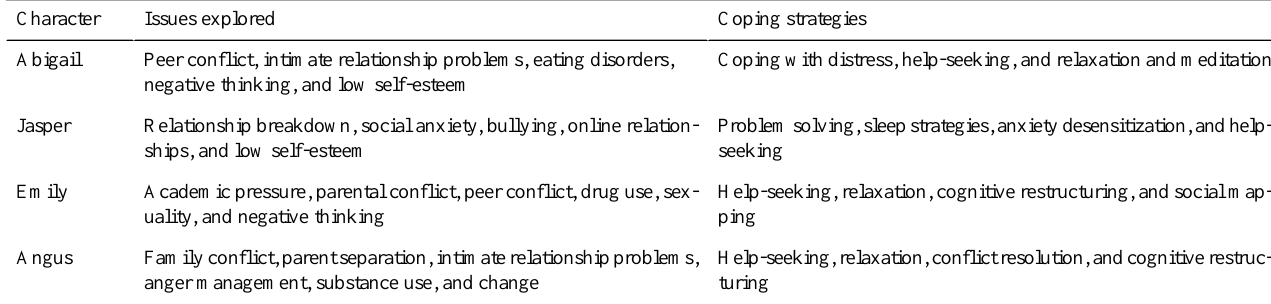
Coping strategiesIssues exploredCharacter Coping with distress, help-seeking, and relaxation and meditationPeer conflict, intimate relationship problems, eating disorders,